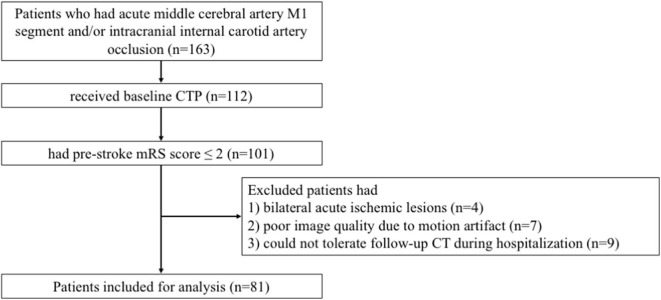
Flow chart of patients screening.